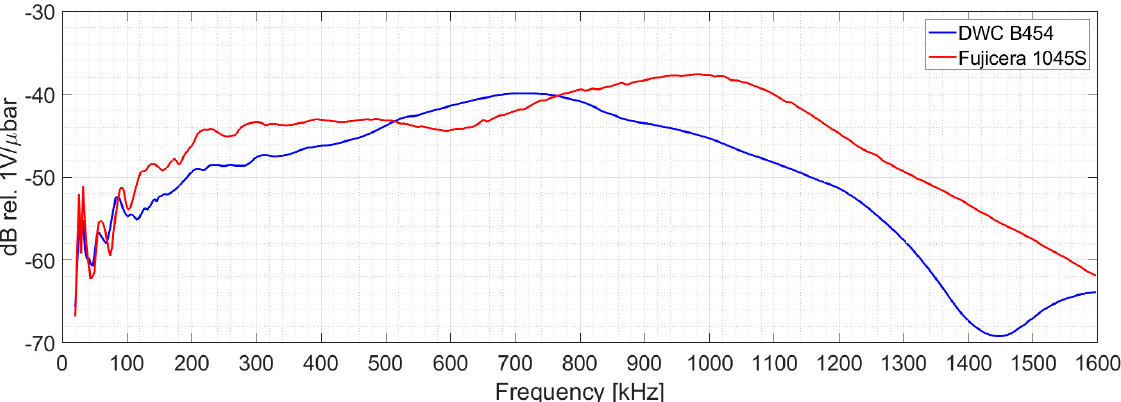
Figure 3. Face − to − face calibration results of DWC B454 and Fujicera 1045S AE sensors using the Vallen Sensor Tester ® utility.